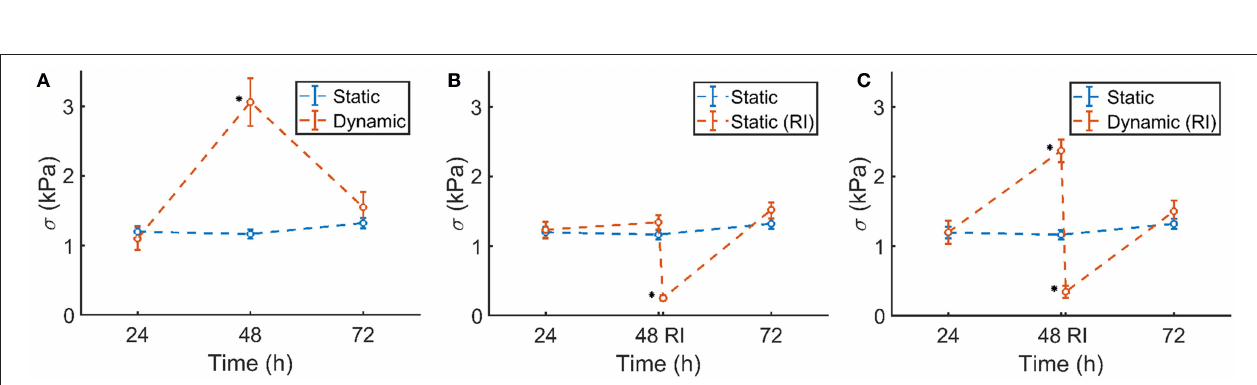
FIGURE 8 | (A) Static control group (blue) and dynamically cultured microtissues (red). (B) Static control group (blue) and ROCK-inhibited (RI, red, at 48 h) microtissues over the course of 72 h. (C) Static control group (blue) and dynamically stretched microtissues (red). A ROCK-inhibitor was added to the dynamically cultured microtissues after 48 h (RI), which was again removed after 30 min. Significant changes ( p < 0.05) between the two groups are indicated by a *. Note that the blue controls in (A–C) are the same experimental group in all figures. The characters of subfigures (A–C) correspond to the characters used in Figure 5 .